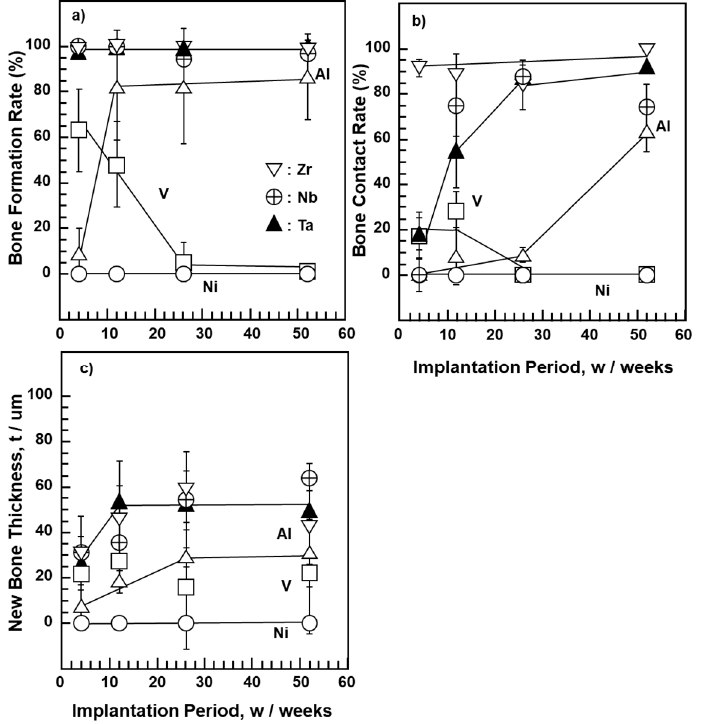
Figure 3. New bone formation rate ( a ), bone contact rate ( b ), and new bone thickness ( c ) for pure V, Ni, Al, Zr, and Nb.